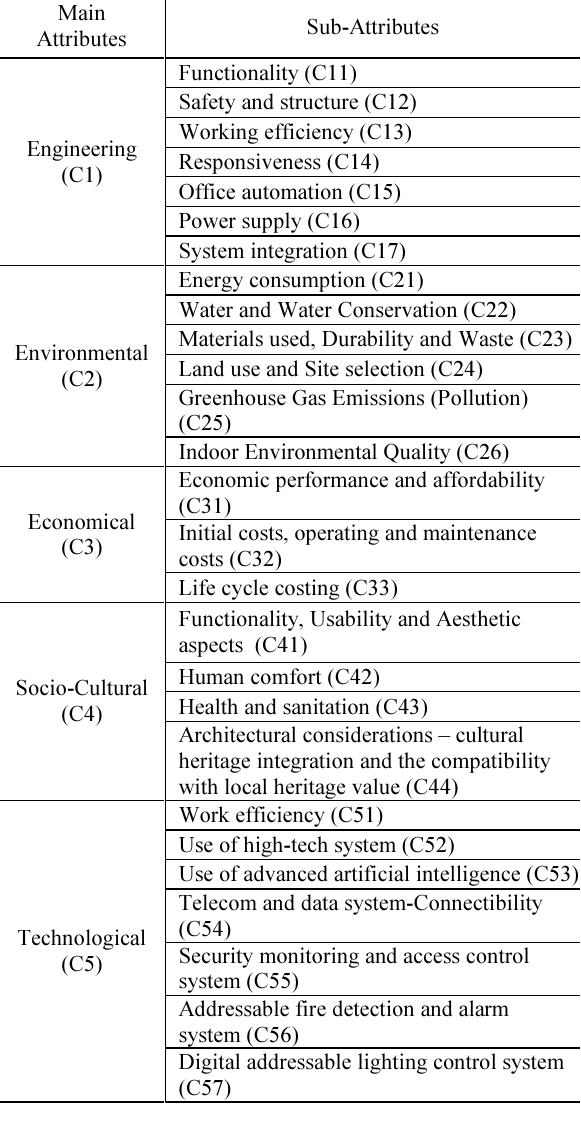
Fig. 3. The linguistic scale for